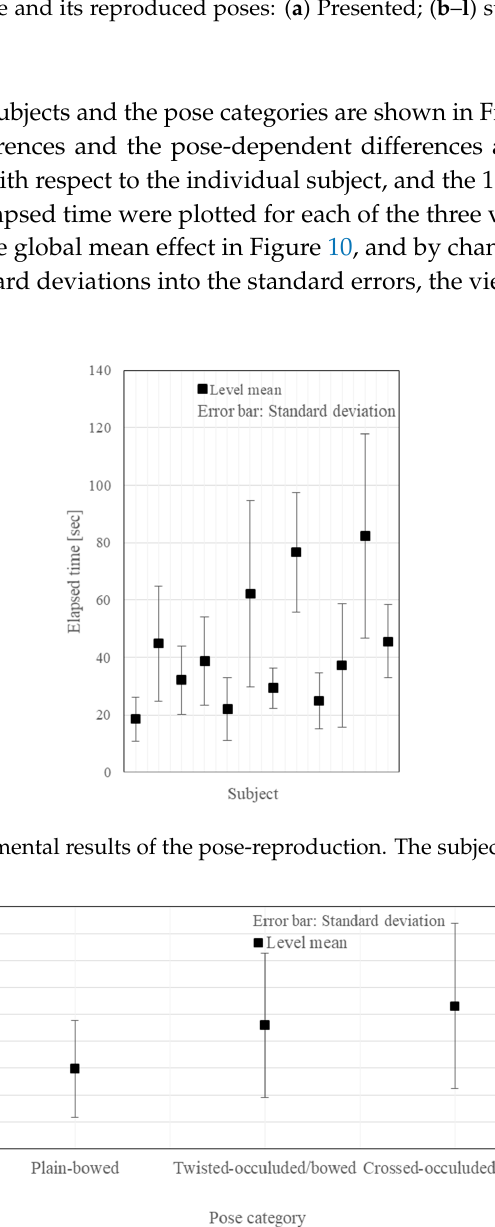
Figure 9. Experimental results of the pose-reproduction. The pose category factor effect.